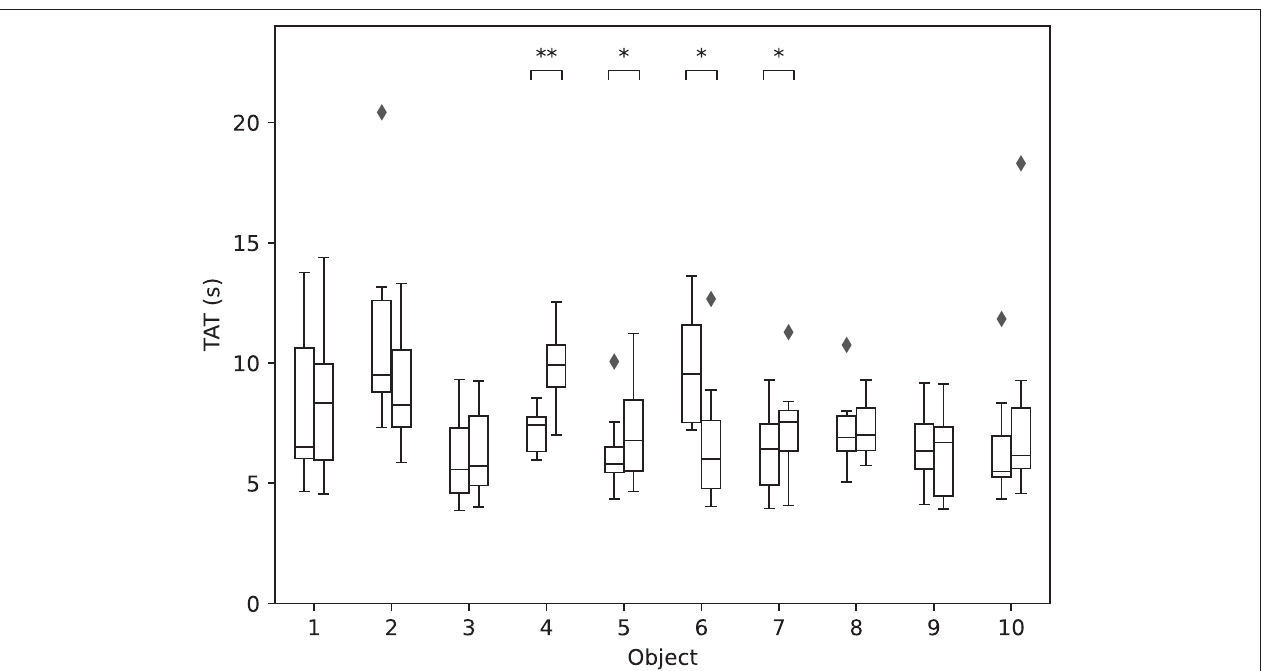
FIGURE 10 | The performance for each of the 10 objects in Phase I vs. Phase II. The boxplots show median TAT per object across all blocks in Phase I (left-hand side) and Phase II (right-hand side). The stars indicate statistical significance (* p < 0.5; ** p <